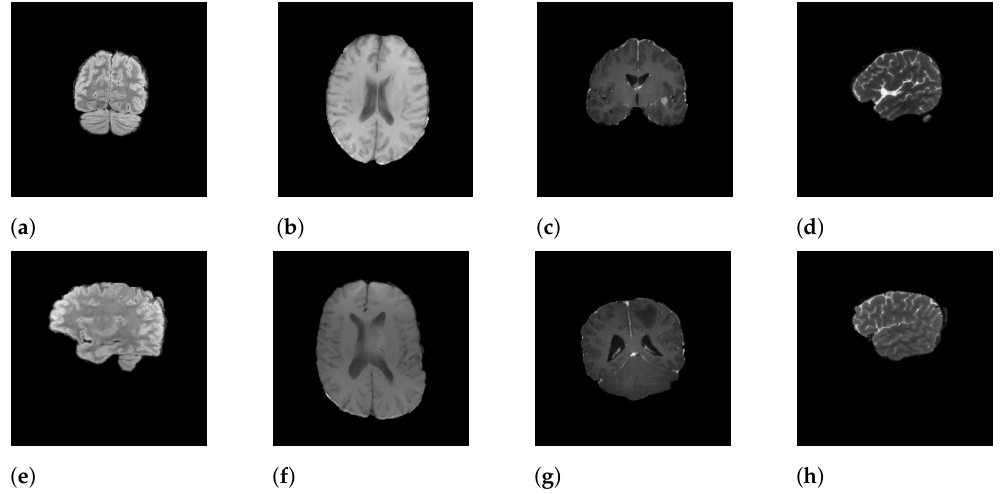
Figure 1. Samples of MRI scans: ( a – d ) represent the FLAIR, T1w, T1Gd, and T2 modalities of a positive sample, and ( e – h ) represent the FLAIR, T1w, T1Gd, and T2 modalities of a negative sample. RSNA-MICCAI has 585 annotated samples, each corresponding to four modalities